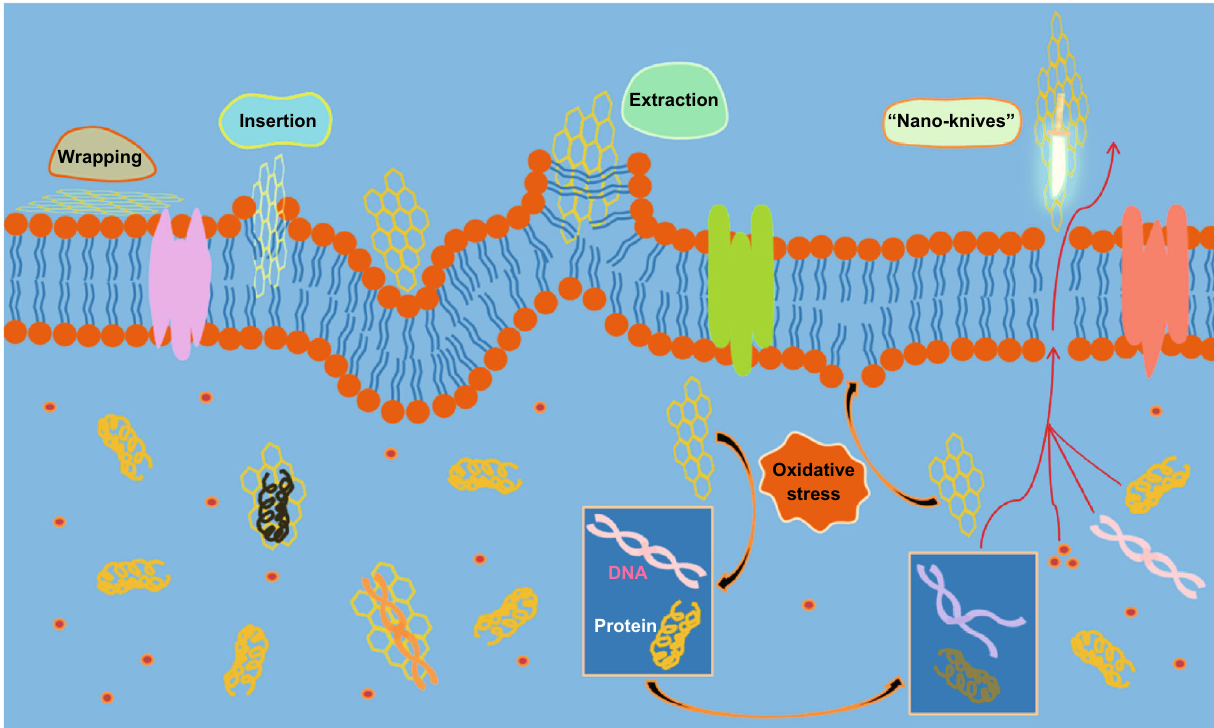
Fig. 6 Schematic mechanism of antibacterial activity of GBNs [161]. Copyright (cid:2) 2016 American Chemical